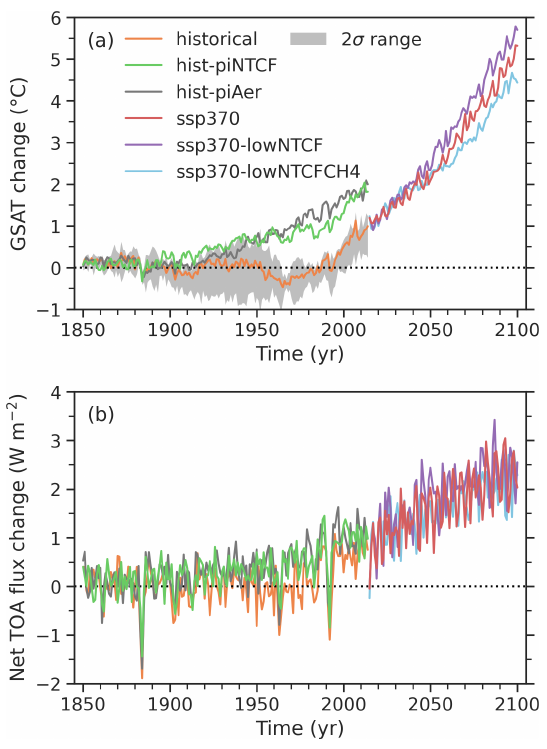
Figure 9. Change in (a) the global surface air temperature (GSAT) and (b) the global net TOA flux in the CMIP6 historical simu- lation, the AerChemMIP historical perturbation experiments hist- piNTCF and hist-piAer, and future simulations for the standard SSP3-7.0 scenario, a corresponding scenario with low NTCF emis- sions (SSP3-7.0-lowNTCF), and a corresponding scenario with both low NTCF emissions and low CH 4 concentrations (SSP3-7.0- lowNTCFCH4). The temperature and flux changes shown in this figure are the annual mean deviations from the preindustrial means given in Fig. 2a and c, respectively. Only the first ensemble member (r1i1p1f1) of each experiment is presented; for the GSAT change in the CMIP6 historical simulation, the range bounded by 2 standard deviations around the mean of the four-member ensemble is also shown.